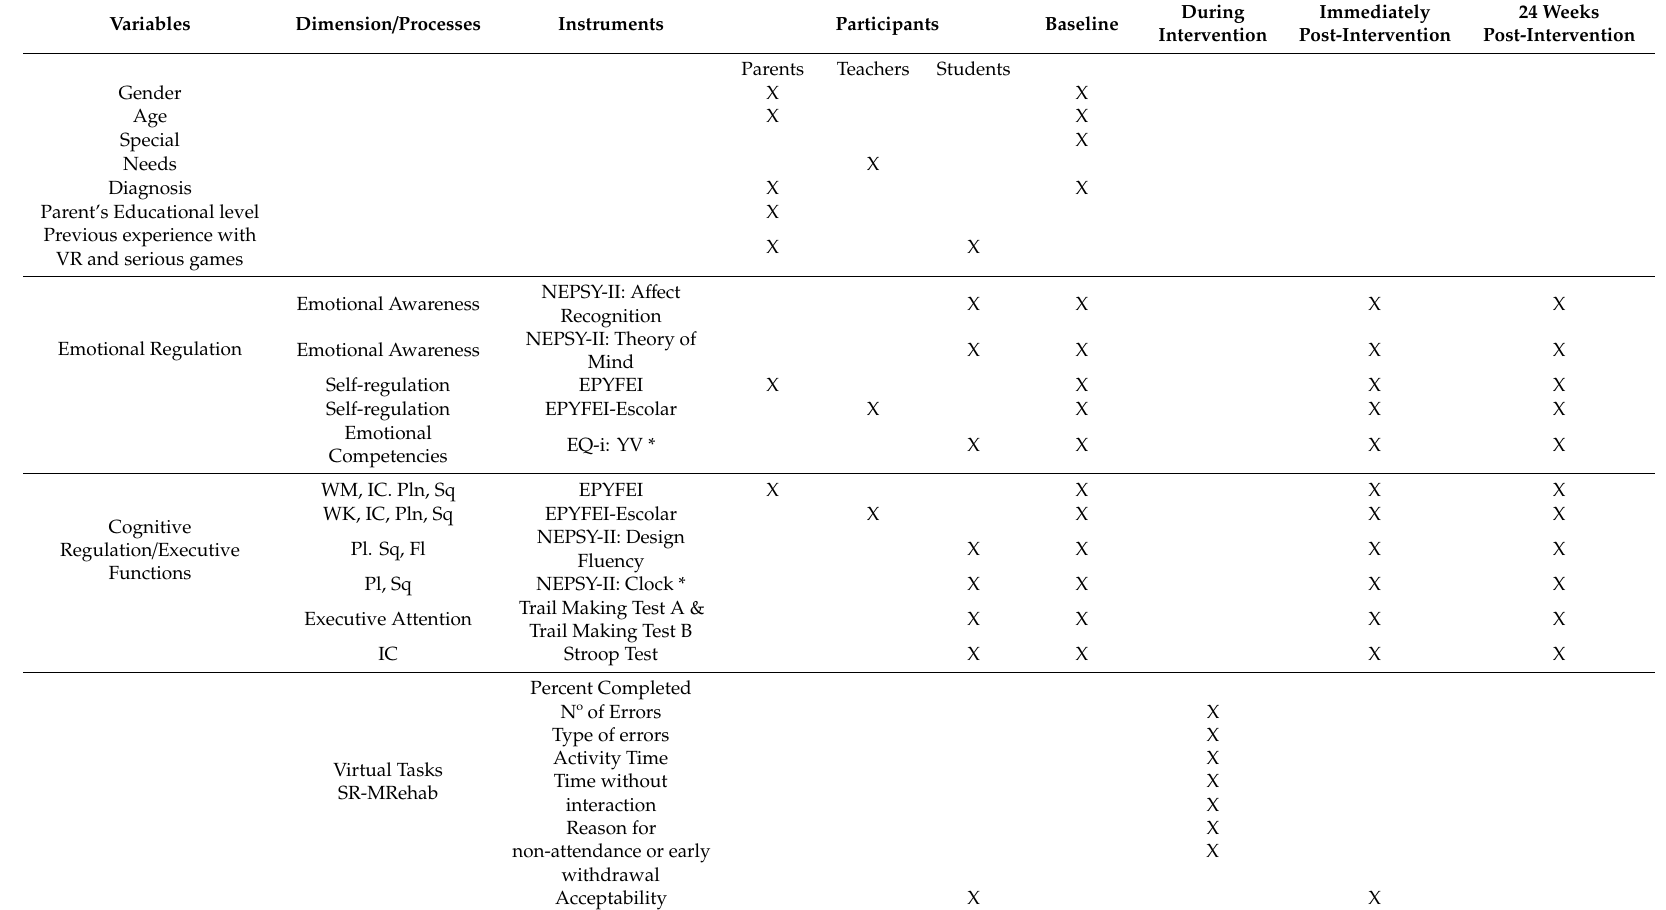
Table 1. Variables and outcome